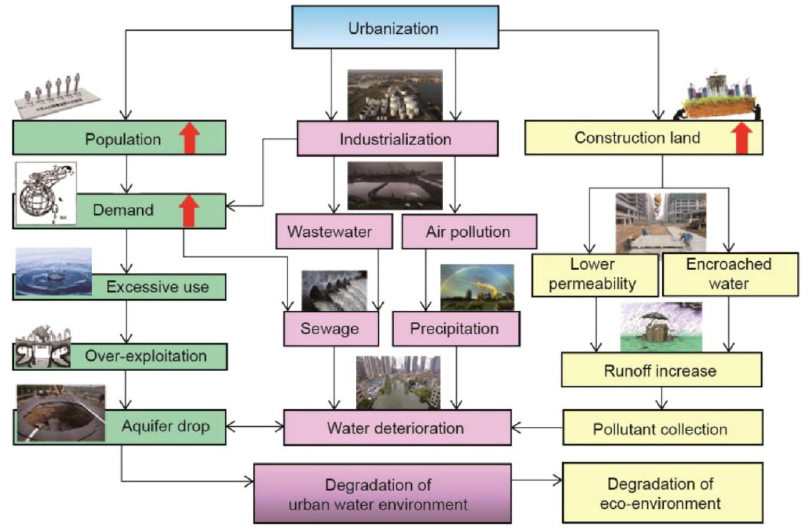
Fig. 1 The structure and external environment of the informatisation teaching